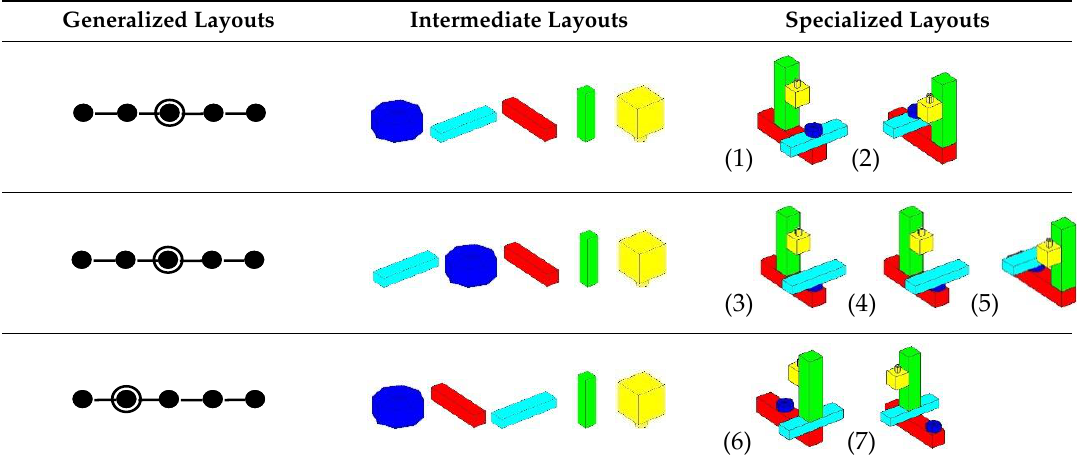
Figure 5. Flowcharts of the module assignment approach. Table 6. Results of module assignment.